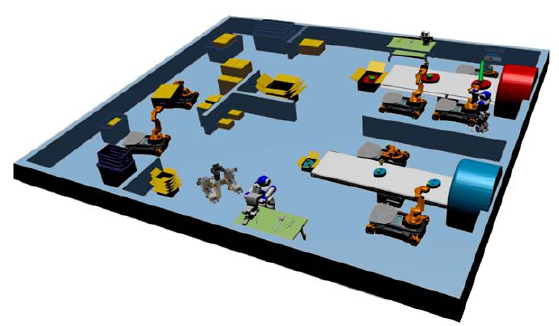
Figure 2. Smart / Cognitive Factory Concept